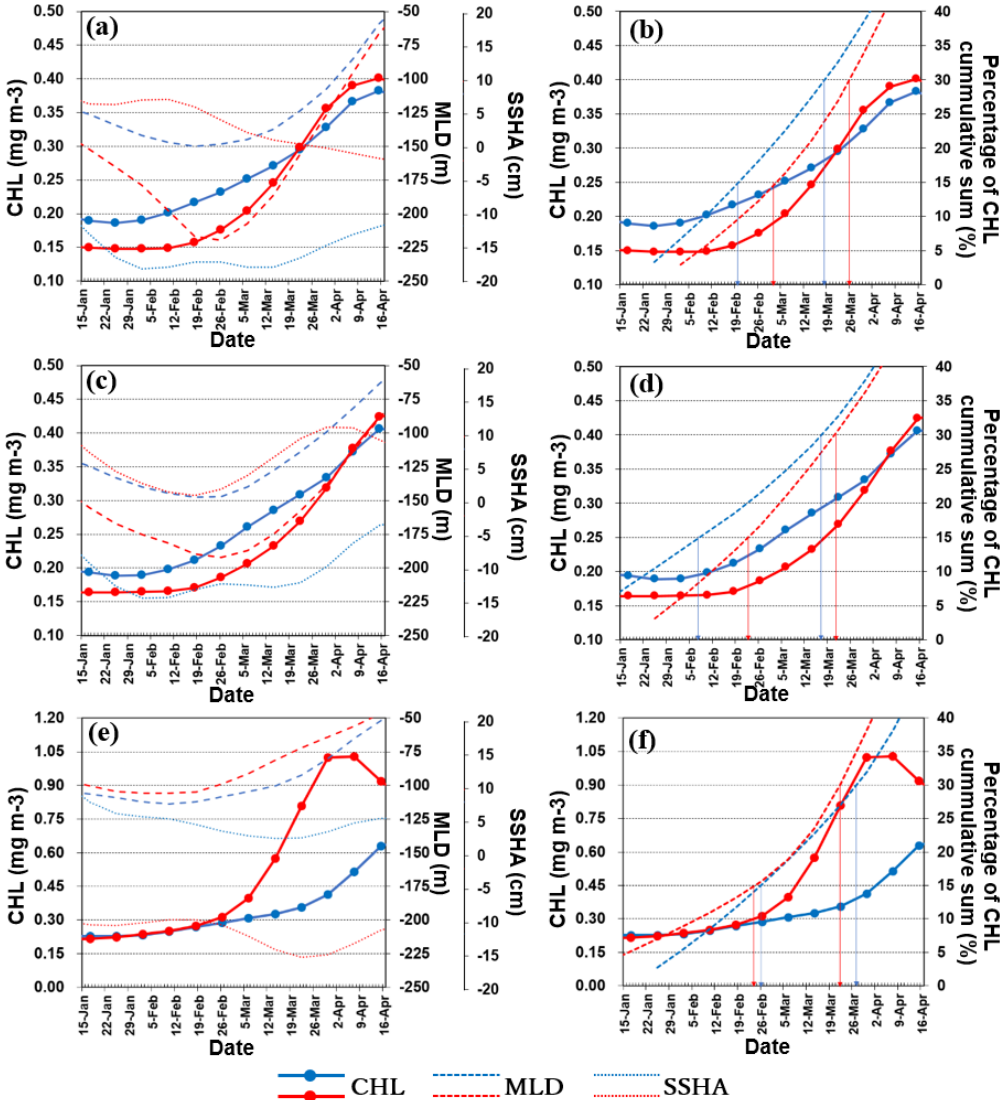
Figure 5. ( a ) Winter–spring mean temporal variations of chlorophyll-a concentrations (CHL) (solid lines with data symbols), mixed layer depth (MLD) (dashed lines), and sea surface height anomalies (SSHA) (dotted lines) averaged over the region indicated by the yellow box in Figure 4b,c. The blue and red lines indicate the data during the unstable and stable periods of the Kuroshio Extension (KE), respectively (see Figure 2e for the years of unstable and stable KEs). ( b ) CHL data as in ( a ) overplotted with their cumulative sum in percentage (dashed lines). Panels ( c , d ) and ( e , f ) are the same as panels ( a , b ) except that they were derived from the regions indicated by green and blue boxes, respectively, shown in Figure 4b,c. The blue (red) downward arrows in ( b , d , f ) indicate the onsets of the spring bloom defined, respectively, by 15 and 30% thresholds during the periods of unstable (stable)